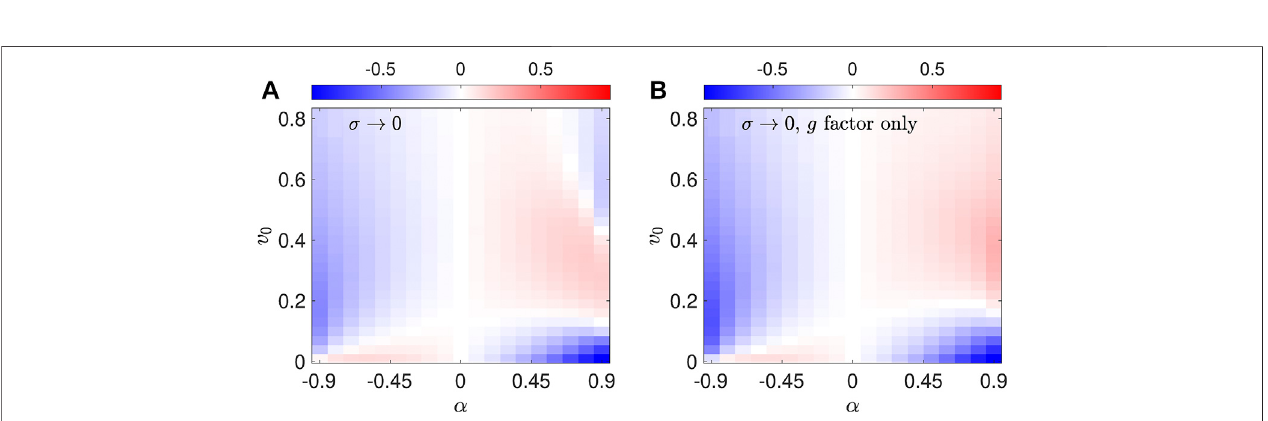
FIGURE 13 | Comparison of calculations of the depletion index I D (A) using P 0 ( y , θ ) vs. (B) using the rotational slowdown fi ltered P 0 (1 − α cos2 θ ) (cid:1) g .